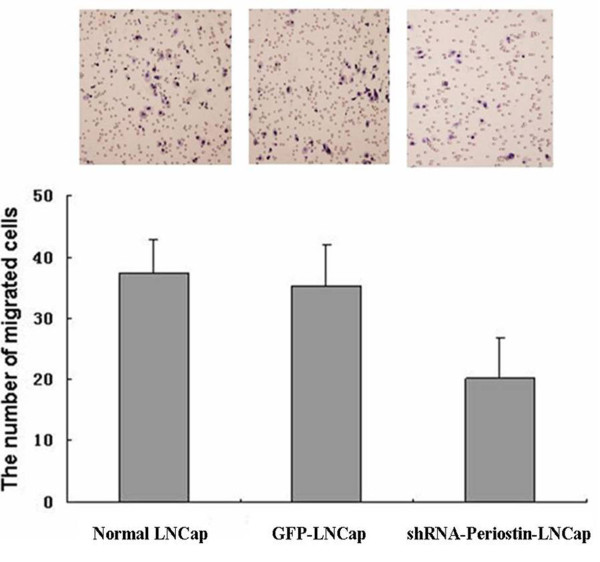
The migration of LNCap cells was detected by Millicell. The number was 37.38 ± 5.53, 35.38 ± 6.57, respectively for the nomal LNCap cells and control GFP LNCap cells. But, the number of migrated cells was 20.25 ± 6.71 in the group of LNCap cells with down-regulated Periostin(P <0.05).